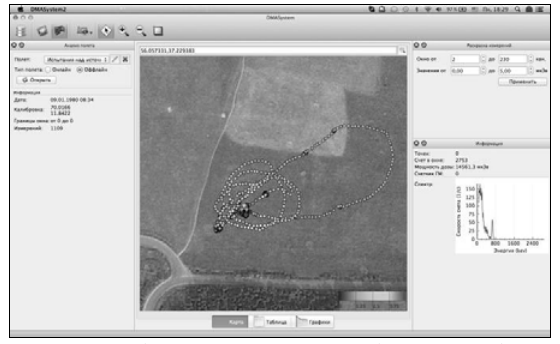
Figure 3. One of the working windows of the RSD software – measurement data display at the